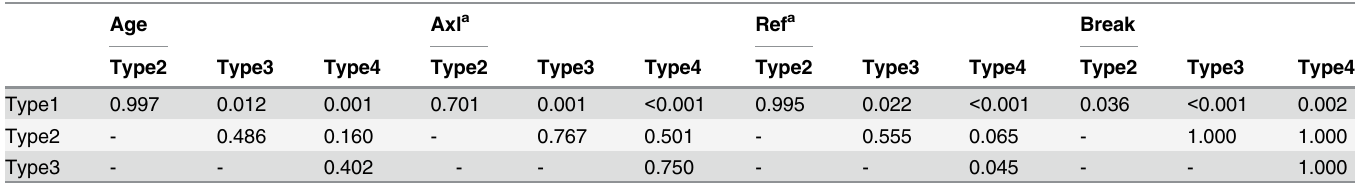
Table 3. P value of Intergroup comparison between types of peripheral vascular patterns in age, axial length, refraction, and location of